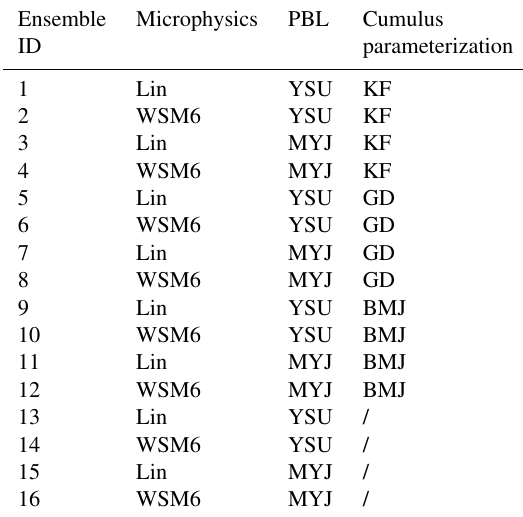
Table 1. The constitution of the WRF physical ensemble.